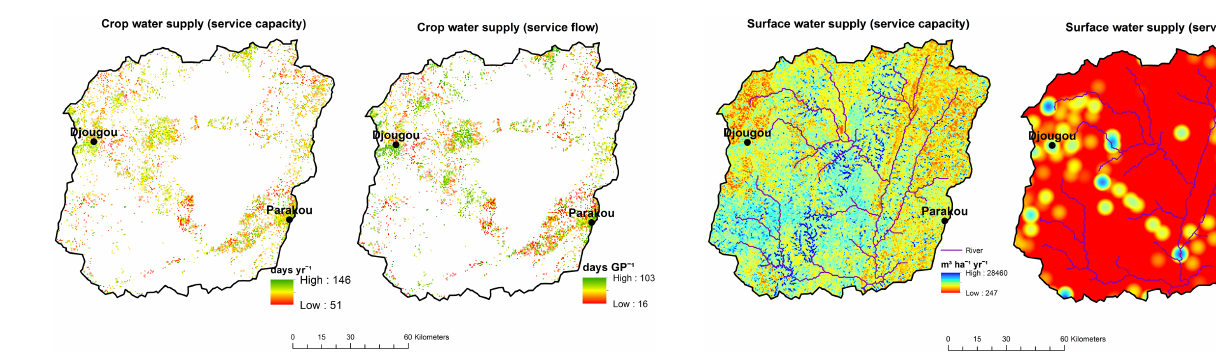
Figure 6. Spatial distribution of mean annual values of service ca- pacity and service flow of surface water supply in the Upper Ouémé watershed from 2001 to 2012.